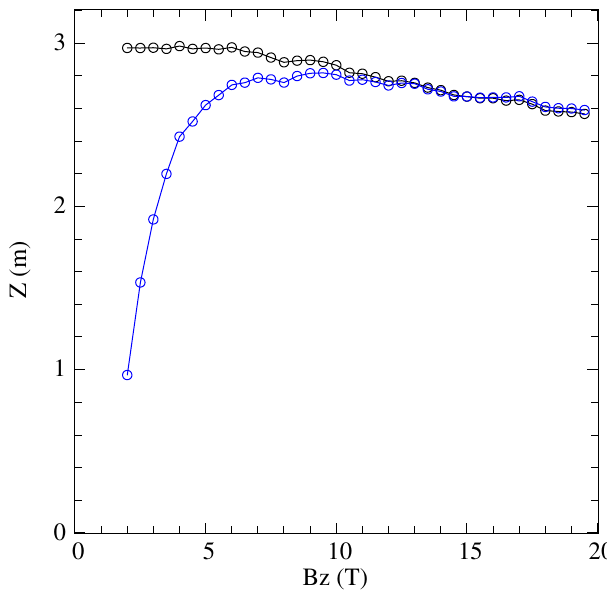
FIG. 6. The location of the solenoid end (blue) and the focal spot and peak compression (black) from the simulation with velocity tilt and thermal spread.